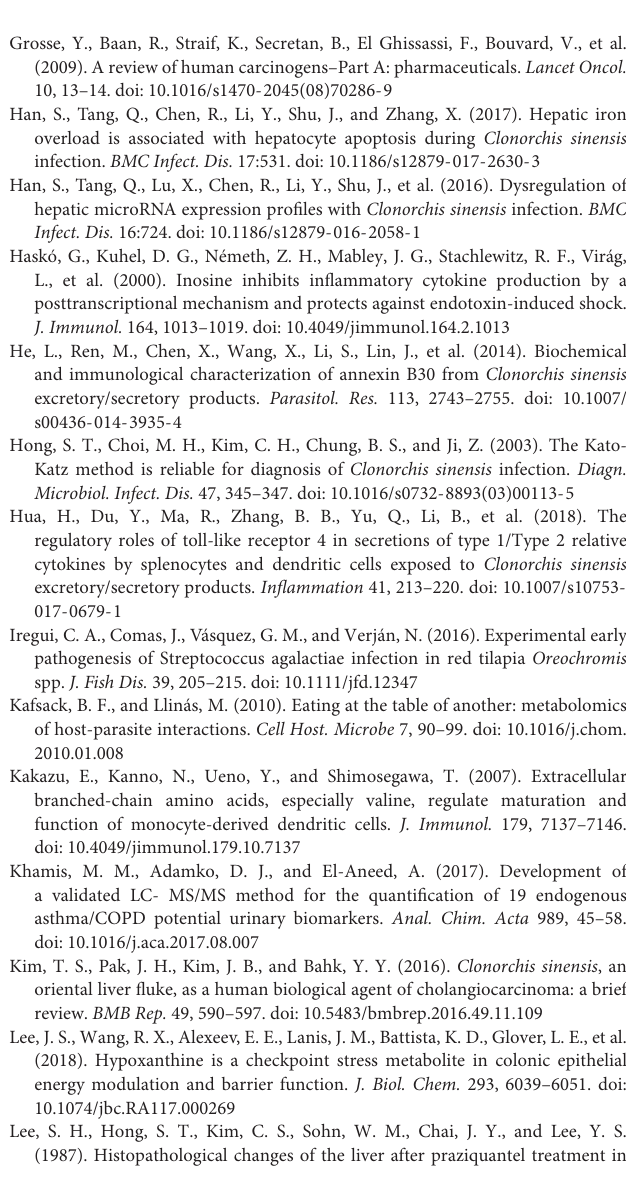
represents significant up-regulation, blue represents significant down-regulation, and gray represents non-significant difference metabolites. Supplementary Figure S5 | Heatmaps representation of the differential metabolites identified between different infection group vs control group in ESI − mode. (A) 4 wpi vs control; (B) 8 wpi vs control; (C) 8 vs 4 wpi; The color blocks at different positions represent the relative expression of metabolites at corresponding positions, red represents up-regulated, and blue represents down-regulated. Supplementary Figure S6 | The distribution of amino acids were present by boxplot between 8 wpi vs control group. (A) L -Valine; (B) L -Asparagine; (C) L -Serine; (D) L -Methionine; (E) L -Phenylalanine; (F) L -Arginine; (G) L -Tryptophan; (H) L -Citrulline; (I) Glycine. Boxes represent the interquartile ranges (IQRs) between the first and third quartiles, and the line inside the box represents the median. The amino acid content was compared with the median value between the two groups. Circles represent outliers. ∗ P < 0.05, ∗∗∗ P < 0.001.